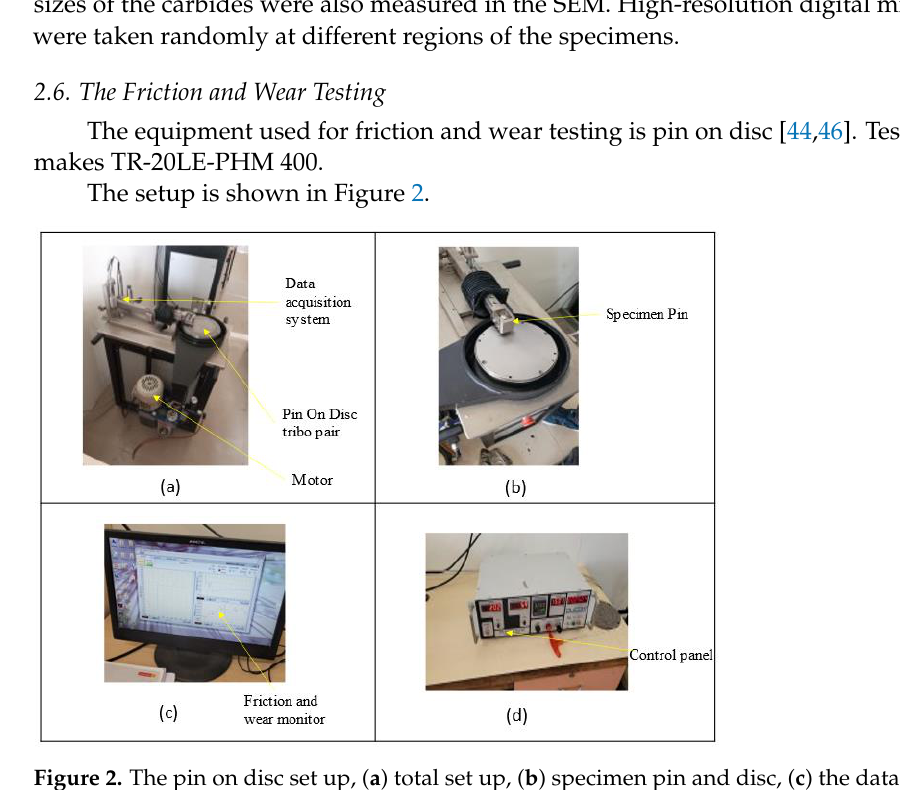
Figure 3. XRD Image of treated pin A7 sample.